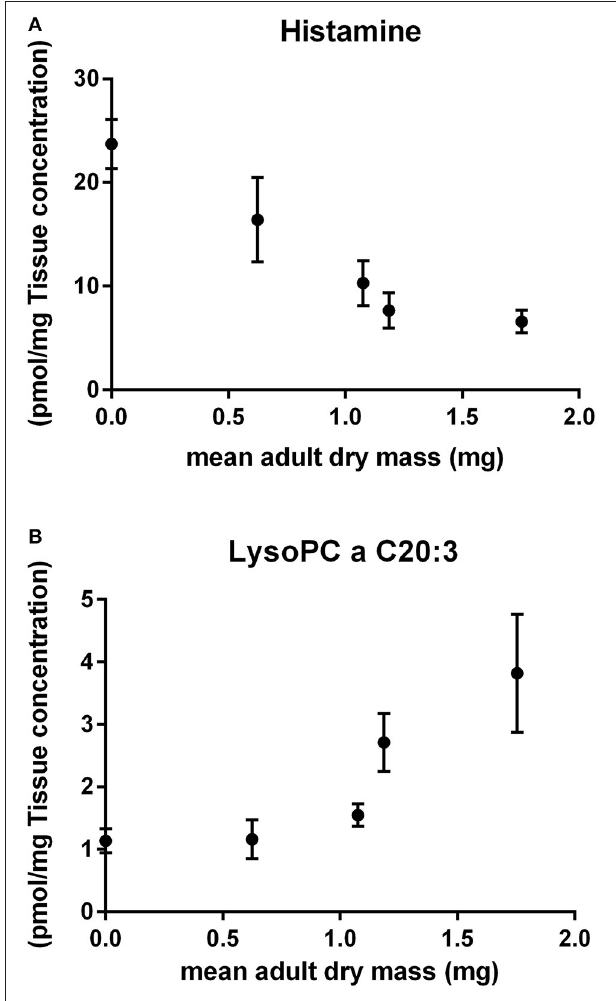
FIGURE 4 | Association of individual metabolites and life history outcomes. (A) Histamine and mean adult dry mass ( r = − 0.96) and (B) lysoPC a C20:3 and mean adult dry mass ( r =